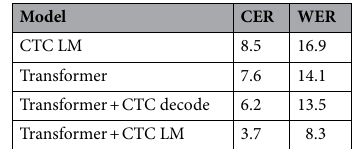
Table 1. Model results on database 1—Read speech.